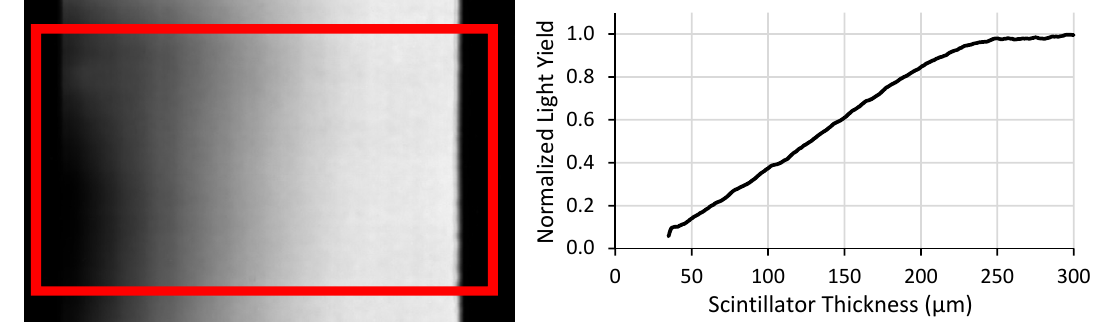
Figure 5. (Left) Light output image from a test-screen with the red box indicating the area that each row’s mean grayscale value was calculated. (Right) The resulting plot of light yield versus thickness.